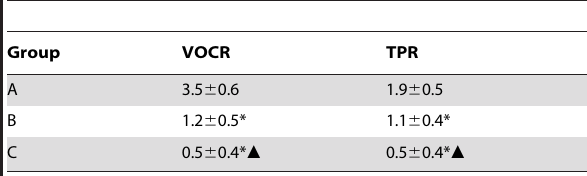
Table 1. Dose-dependent group-average effects of propofol on VOCR and TPR.